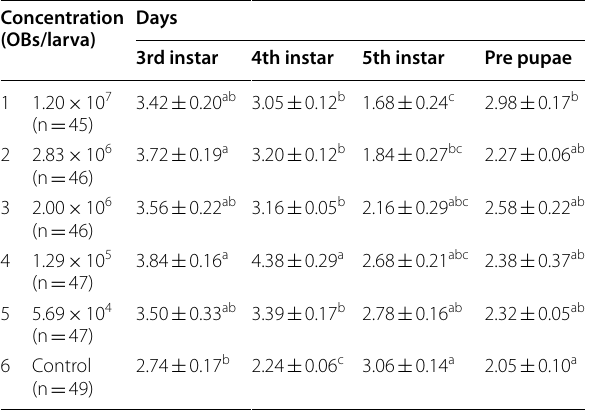
Within columns, mean number of days followed by the same letter do not differ significantly [ANOVA, Tukey’s HSD; P < 0.01]